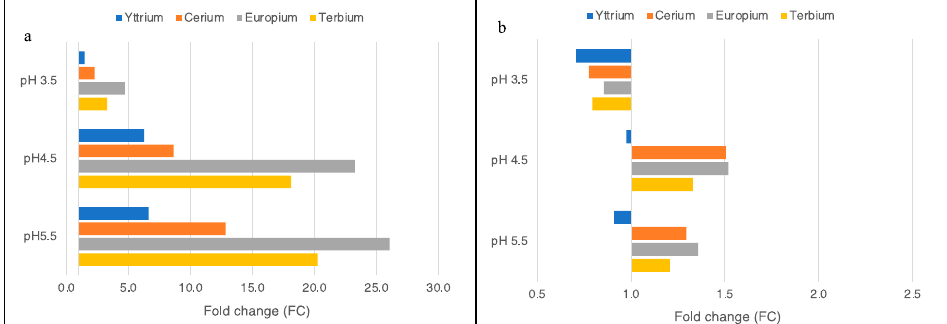
Figure 4. Fold change of the total metal removed from the quaternary-metal aqueous solutions by G. sulphuraria , strains SAG 107.79 ( a ) and ACUF 427 ( b ). The fold change was calculated by comparing the µmol/g dm of every metal obtained at pH 3.5, 4.5, and 5.5 with the µmol/g dm measured at pH 2.5.